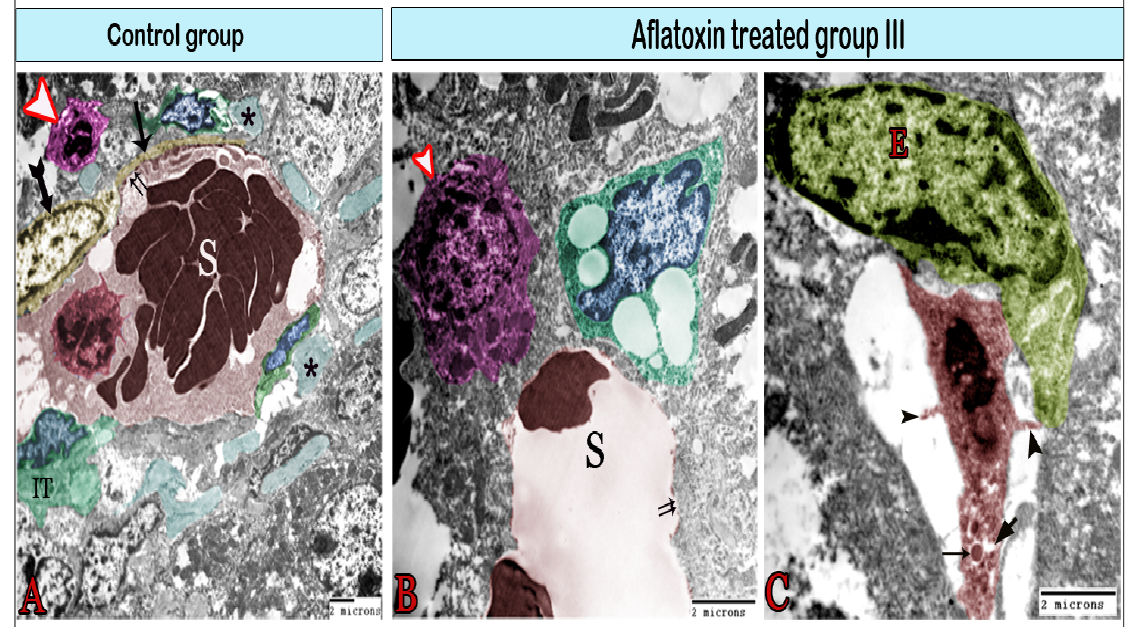
Figure 7. Digital colored transmission electron microscopy micrographs of the control group ( A ) and aflatoxin B1-treated group III ( B, C ). ( A ) Blood sinusoid (S) lined with fenestrated endothelium (double arrows). The lumen of the sinusoid contains Kupffer cells (red). The blood sinusoid is surrounded by telocytes (TCs; yellow), Ito cells (IT) containing fat droplets, and pit cells (arrowhead). Note the TCs’ cell body (biforked arrow), telopodes (arrow), and bundles of collagen fibers (*). ( B ) Blood sinusoid in the aflatoxin B1-treated group exhibiting a large gap in the endothelial lining (double arrows). It is surrounded by enlarged pit cells (arrowhead) and Ito cells (IT) which are overloaded with large fat droplets. ( C ) Kupffer cells (red) are located within the sinusoid and attached to the endothelial cell (E) through its cytoplasmic extensions (arrowheads). They contain lysosomes (arrow) and vacuoles (V).